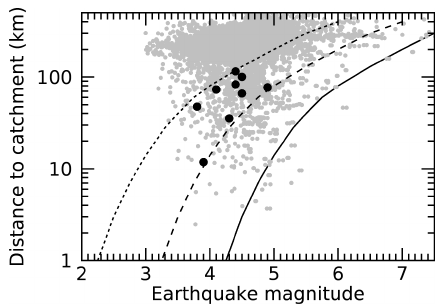
Figure 10. Proximity and magnitude of earthquakes which occurred within a 500km radius around the analyzed catchment areas (gray dots). The solid line indicates the threshold for triggering disrupted landslides (Jibson, 2013); the dashed and dotted lines represent the same line but shifted by 1 and 2 magnitudes, respectively. Black dots indicate earthquakes that occurred between a pre- and post- event image of the analyzed events and that are closer or stronger to be located below the dotted threshold.